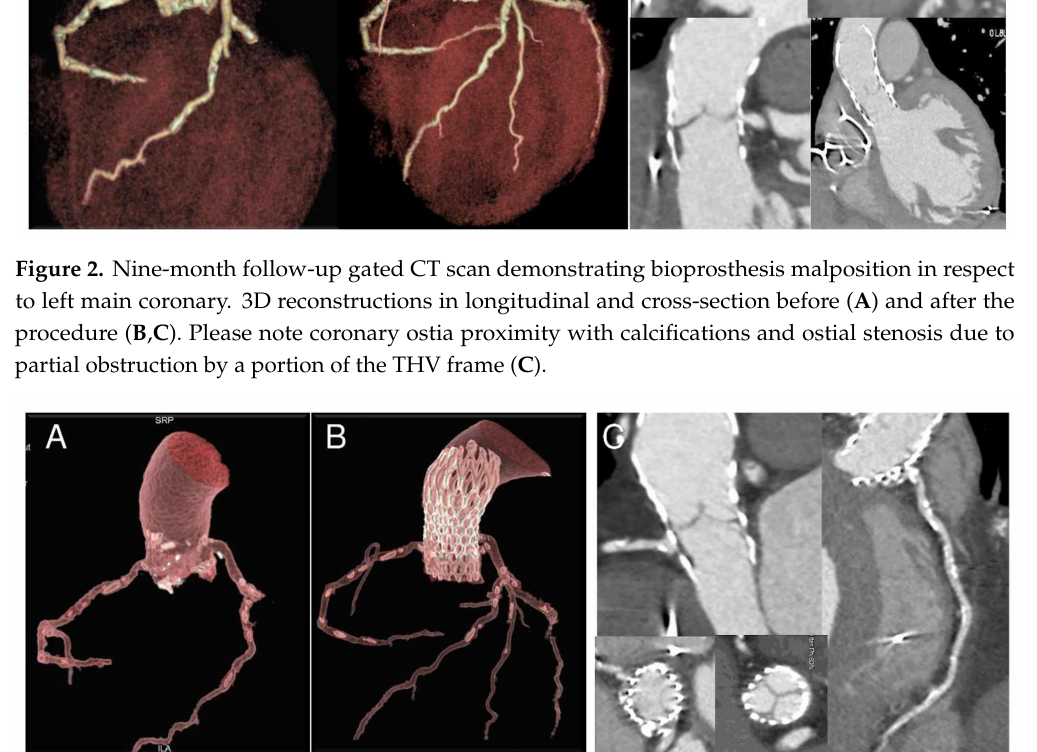
Figure 3. Nine-month follow-up gated CT scan demonstrating bioprosthesis malposition in respect to right coronary. 3D reconstructions in longitudinal and cross-section before ( A ) and after the procedure ( B , C ). Please note ostia proximity with calcifications and ostial stenosis due to partial obstruction by a portion of the bioprosthesis frame ( C ).